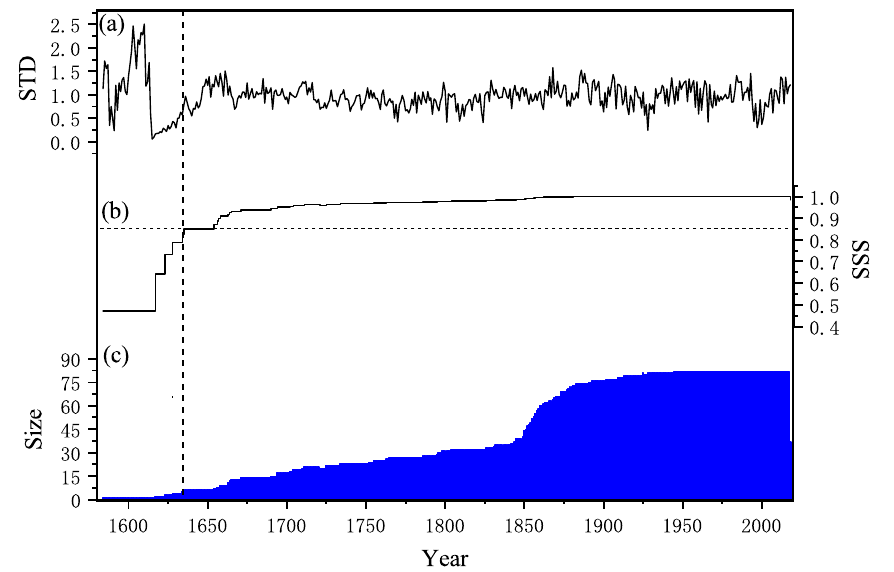
Figure 1. ( a ) The composite chronology developed from GQM and SMM; ( b ) the running SSS statistics. The horizontal dashed line denotes the 0.85 cutoff value; ( c ) the corresponding sample size. The vertical dashed line denotes when SSS > 0.85, the corresponding reliable STD and the sample